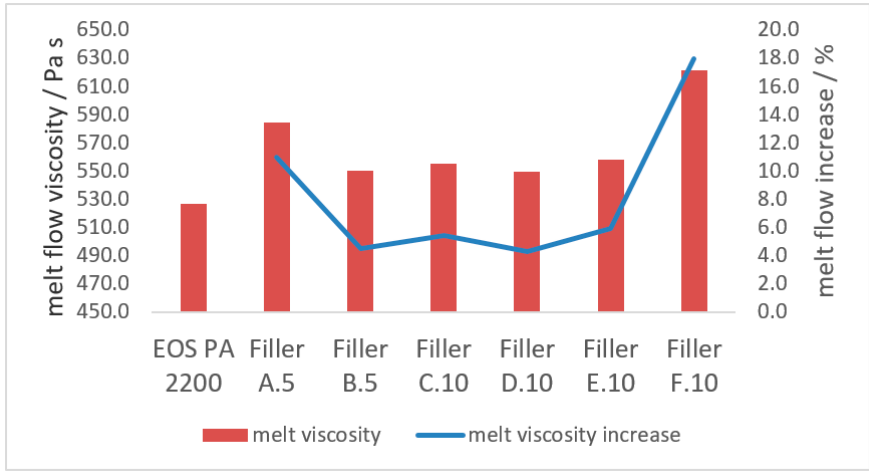
Figure 6. Melt properties–melt viscosity comparison at 190 °C, 2.16 kg.